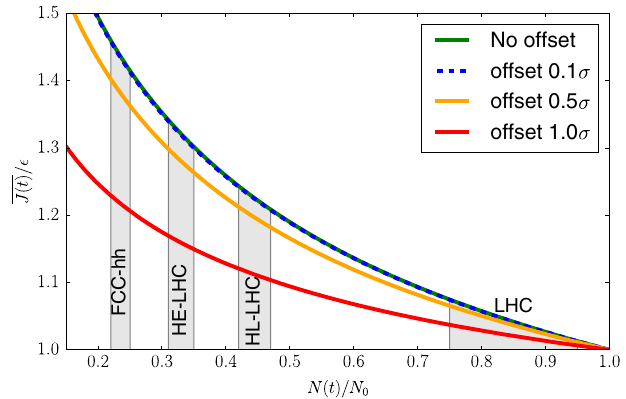
FIG. 10. Emittance growth versus bunch population with offset